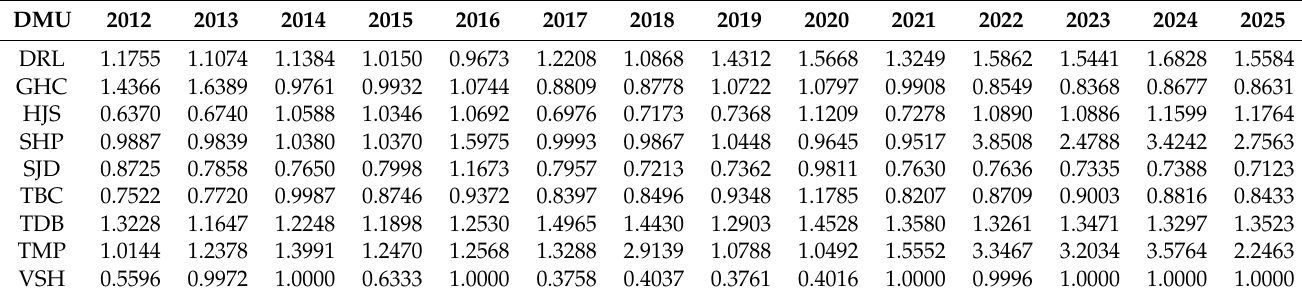
Table 5. Efficiency of hydropower suppliers from past to